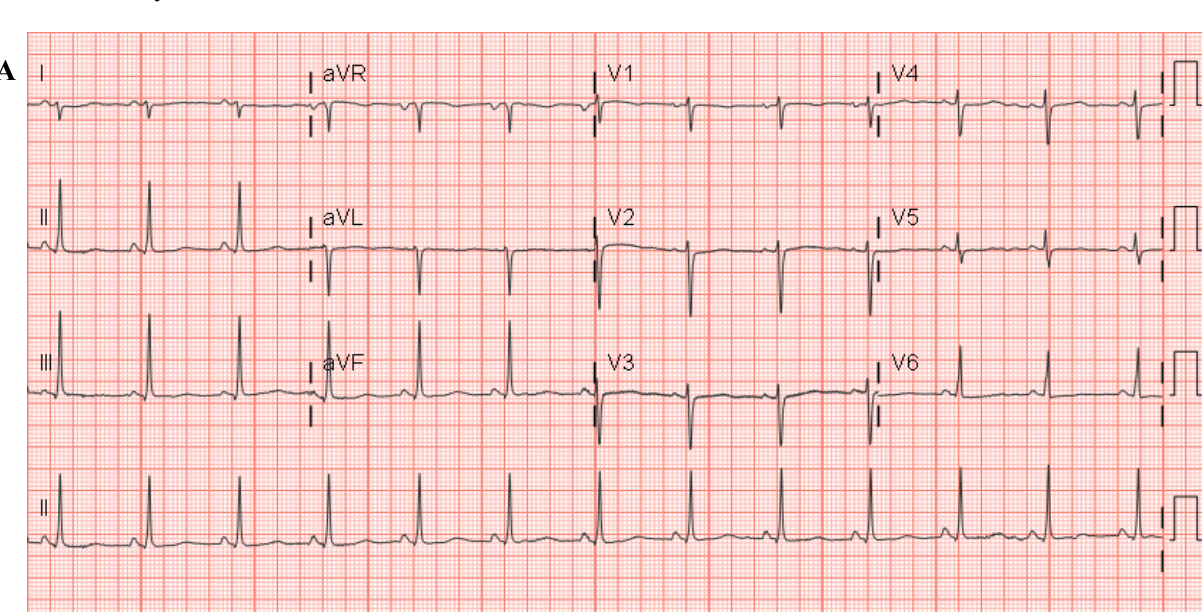
Figure 11. Conventional ECG for Case 2 ( A ); ( B ) A-ECG-related discriminant analysis results for Case 2 using multiple advanced ECG parameters. Red circle = Coronary Artery Disease (CAD) population; Aqua circle = Left Ventricular Hypertrophy (LVH) population; Blue circle = Hypertrophic Cardiomyopathy (HOCM) population; Purple and Orange circles = Non-Ischemic (NICM) and Ischemic (ICM) Cardiomyopathy populations; ( C ) Angiogram results for Case 2: occluded left anterior descending, left circumflex and right coronary